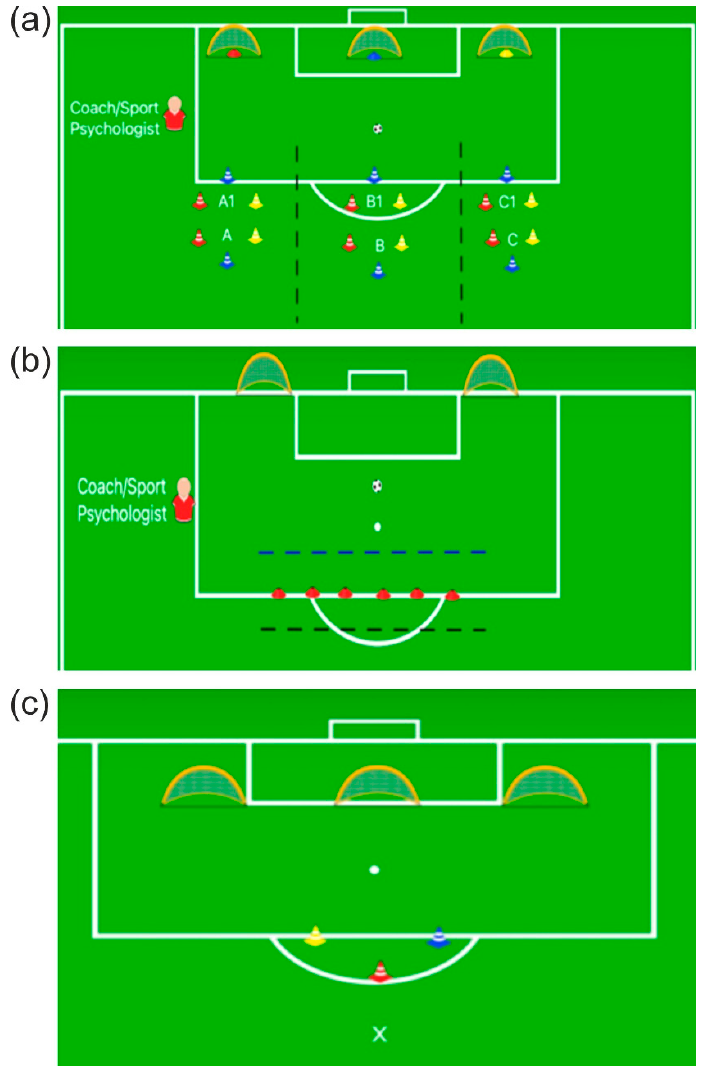
Figure 3. Representation of the first (a), the second (b), and the third task (c) of the experimental treatment, which were repeated